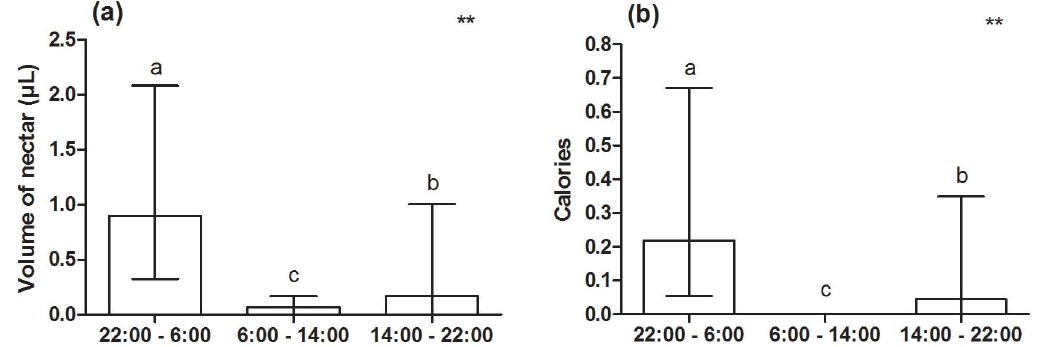
Fig 1. Total volume of nectar (a) and quantity of calories (b) produced at the EFNs in the group of plants (seven species) assessed at three distinct times of the day. The bars represent the medianand the interquartile range. Friedman test F = 59.36; n = 70; p < 0.001 for (a), and F = 63.65; n = 64; p < 0.001. The letters represent the difference amongthe three times of the day accordingto